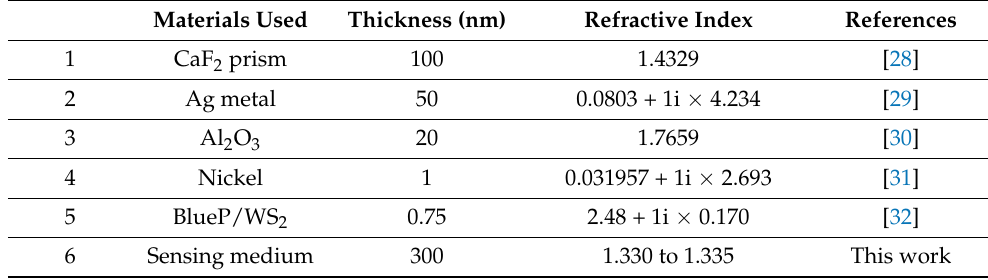
Table 1. Details of each layer of the proposed biosensor at 633 nm